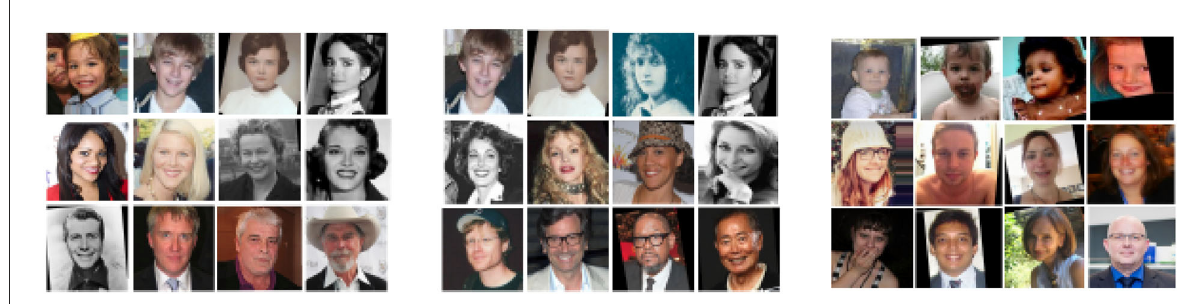
FIGURE3 Sample images from LAP-2015, LAP-2016, and APPA-REAL datasets. LAP-2015 and LAP-2016 datasets were collected purposely for the Chalearn looking at people (LAP) competition in 2015 and 2016, respectively. It contains facial images with apparent ages. APPA-REAL dataset, on the other hand, was introduced by Agustsson et al. (2017) and contained images with both real and apparent age